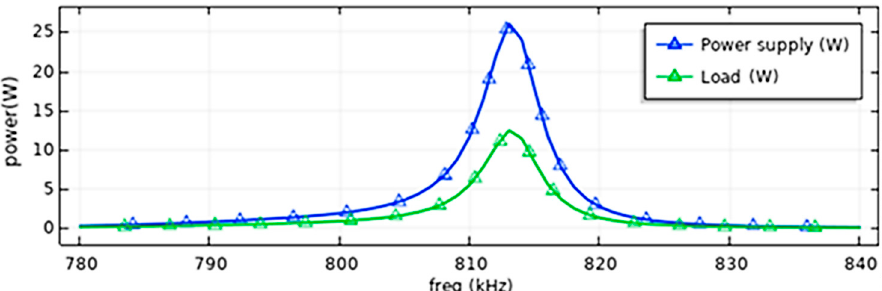
Figure 12. The relationship between power supply and load power and operating frequency.